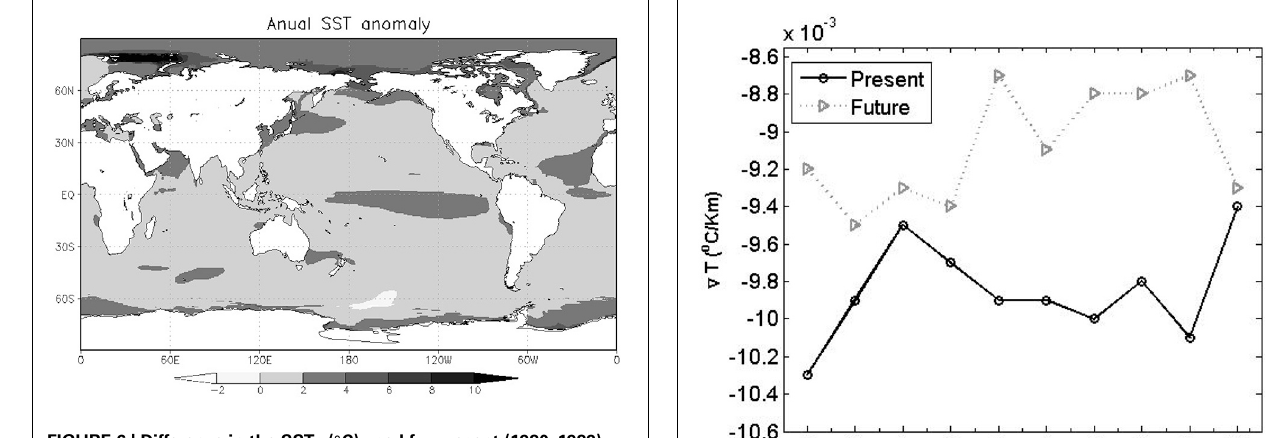
numerical experiments shows a decrease in intensity as deter- mined in the meridional temperature gradient over the domain of study ( Figure 7 ).